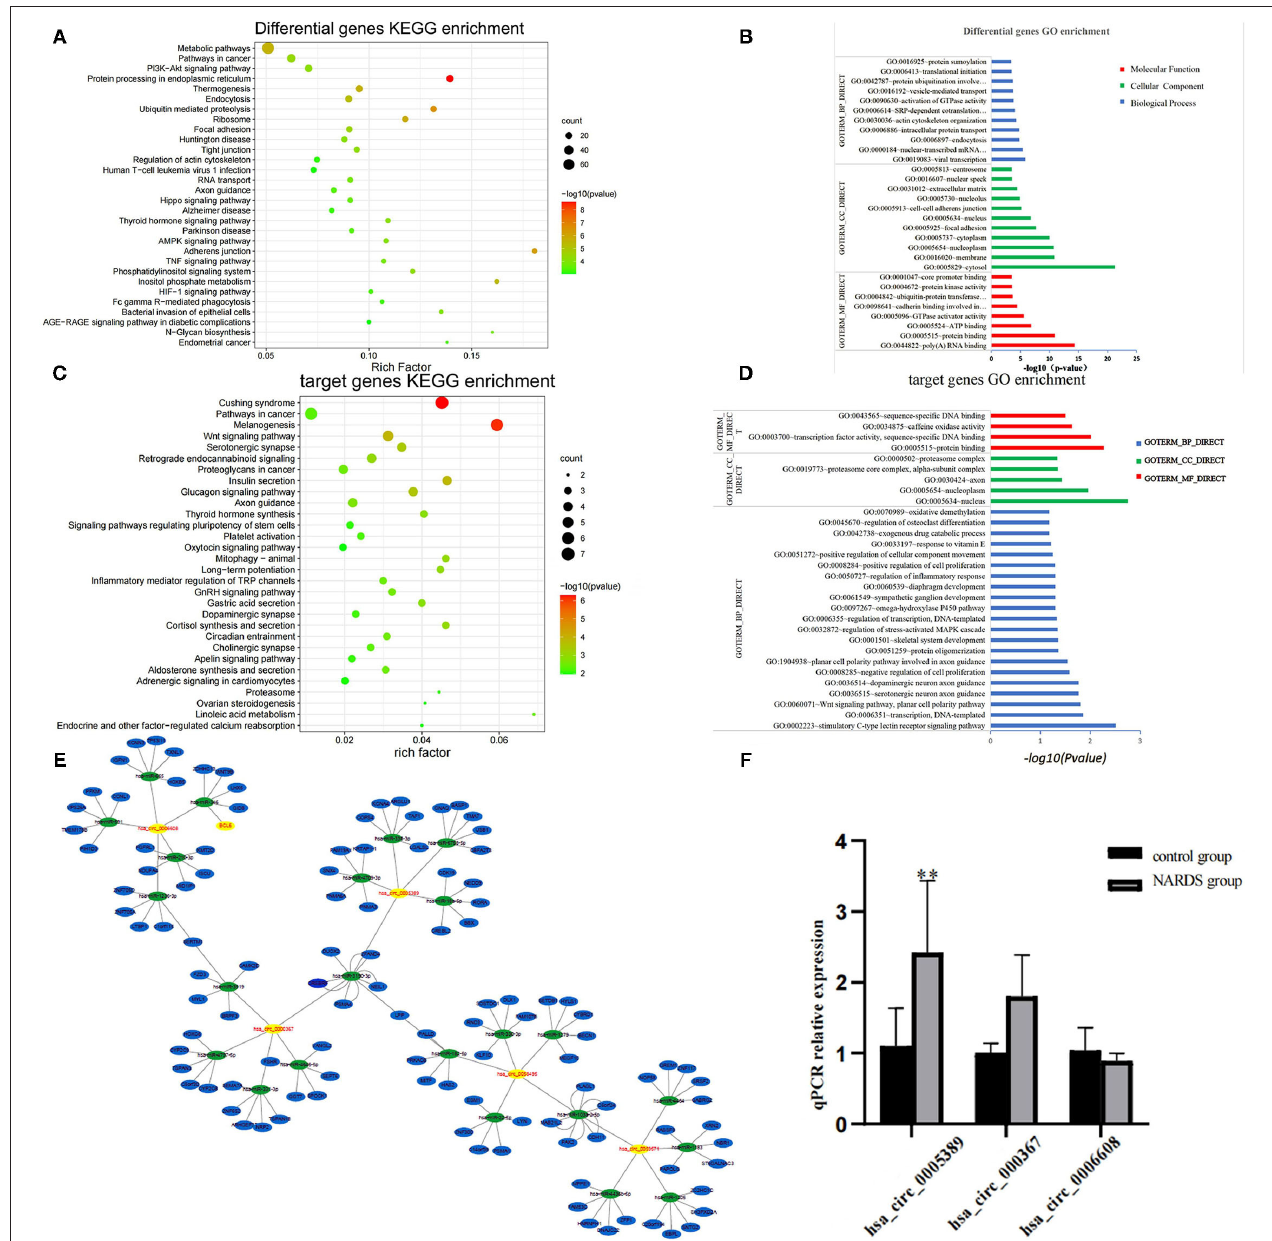
FIGURE 3 | Bioinformatics analysis. (A) The y-axis represents the top 30 enriched KEGG pathways of differentially expressed circRNAs in NARDS. The x-axis stands for the enriched factors. (B) Top 30 GO-enriched terms based on the parent genes of differentially expressed circRNAs are demonstrated on the y-axis, and the negative logarithm of the p -value of enriched terms is shown on the x-axis. (C) Top 30 KEGG pathways of target genes were described according to the enrich factors of enriched target genes. (D) Top 30 enriched GO terms according to the negative logarithm of the p -value of enriched target genes. (E) Bioinformatics prediction of circRNA–miRNA–mRNA network. (F) RT-qPCR validation of selected circRNAs. It has a similar reflection to the drift of three differentially expressed circRNAs and hsa_circ_0005389 has a significant statistical difference. KEGG, Kyoto Encyclopedia of Genes and Genomes; GO, Gene Ontology; miRNA, microRNA; mRNA, messenger RNA; ** p <